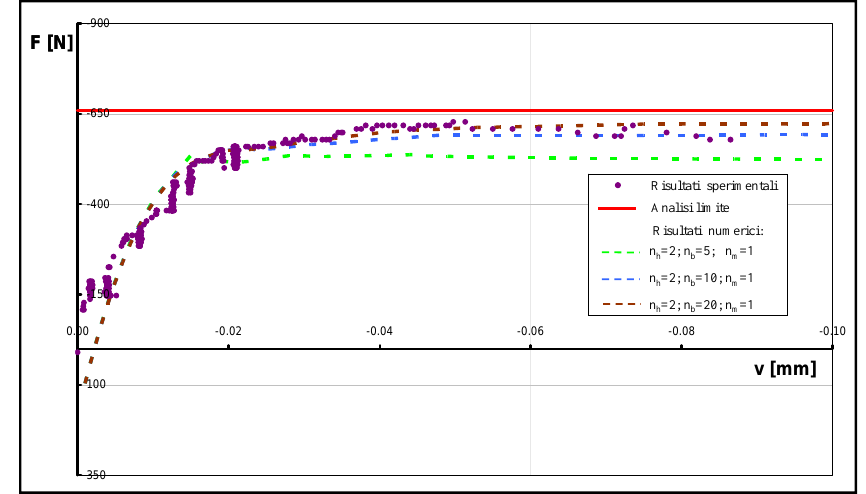
Figura 13: Risultati del primo gruppo di